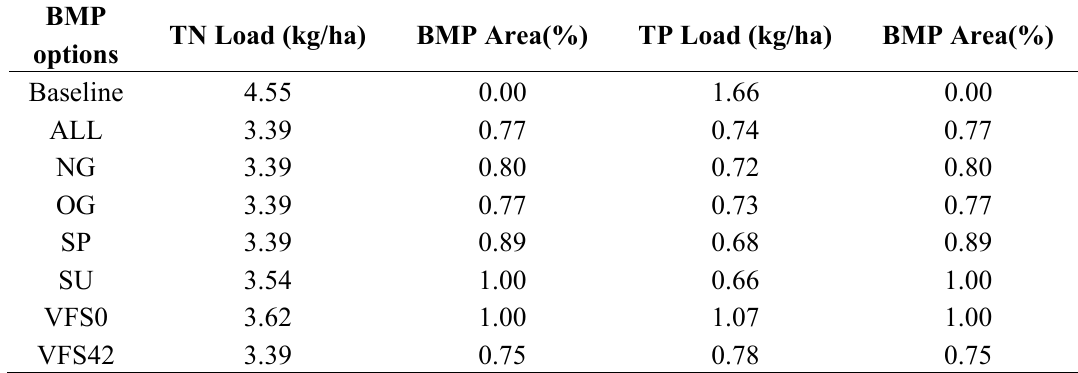
Table 3. Solutions from other models which at least meet the same pollutant reduction of the model with 171 BMP